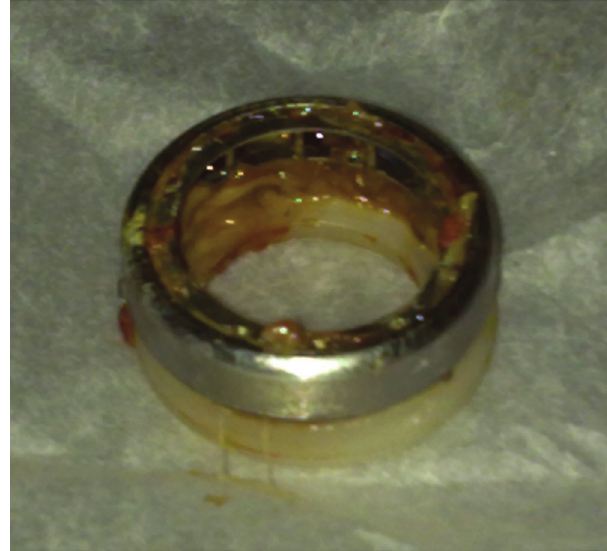
Figure 4 - The evacuated NiTi compression anastomosis ring (NiTi CAR 27).